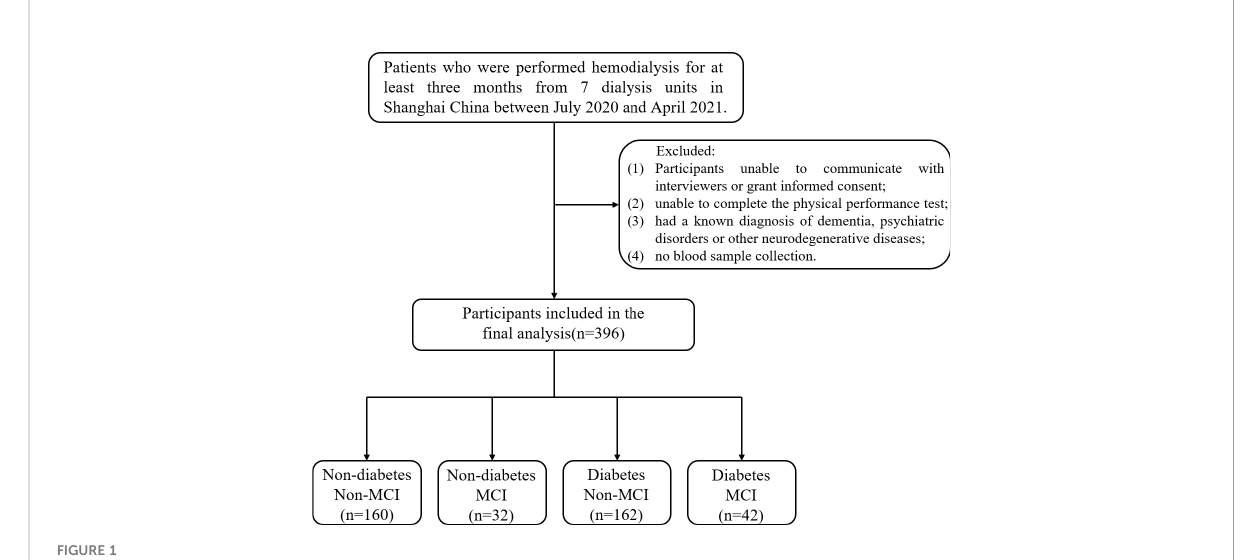
FIGURE 1 Flow diagram of the study. MCI, mild cognitive